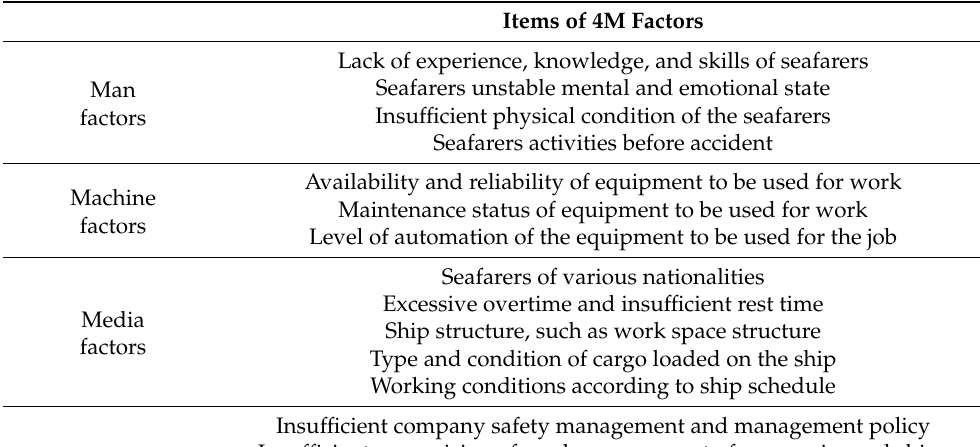
Table 1. Classification of items by 4M factors in consideration of IMO Res